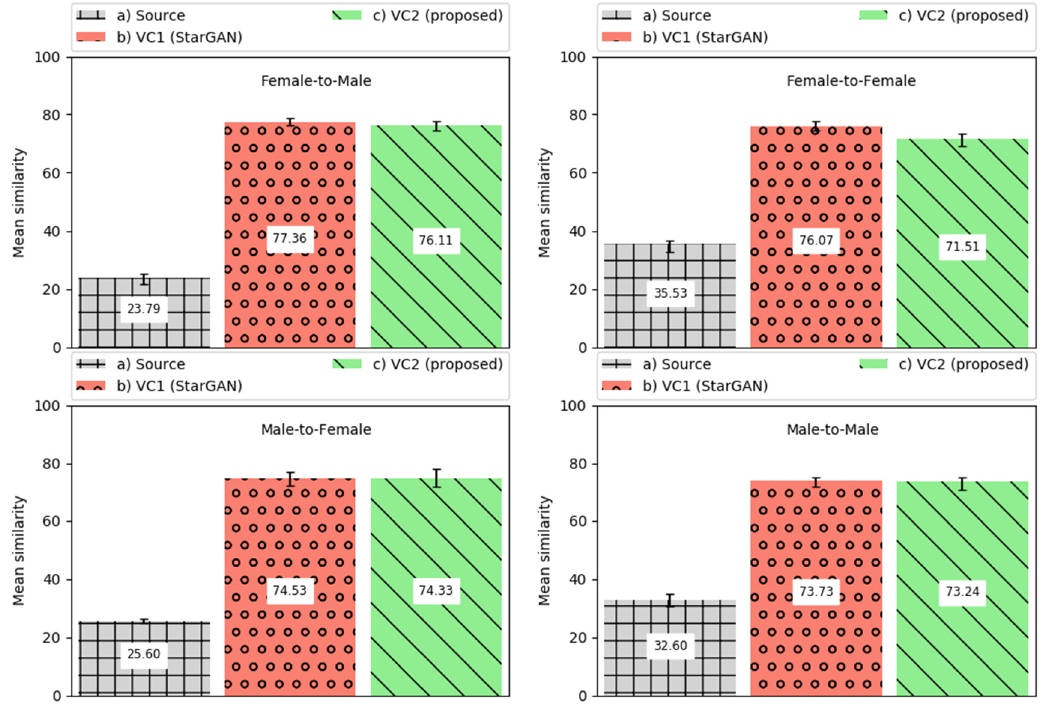
Figure 7. Results of the speaker similarity test.